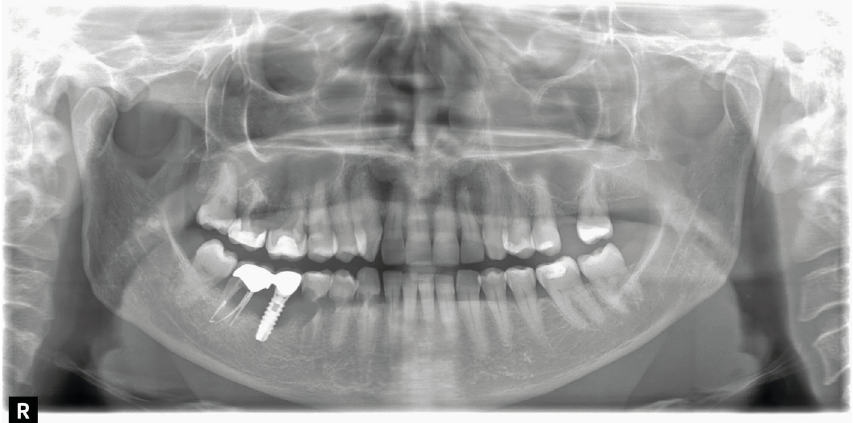
Figure 2: Tooth resorption and worsening of